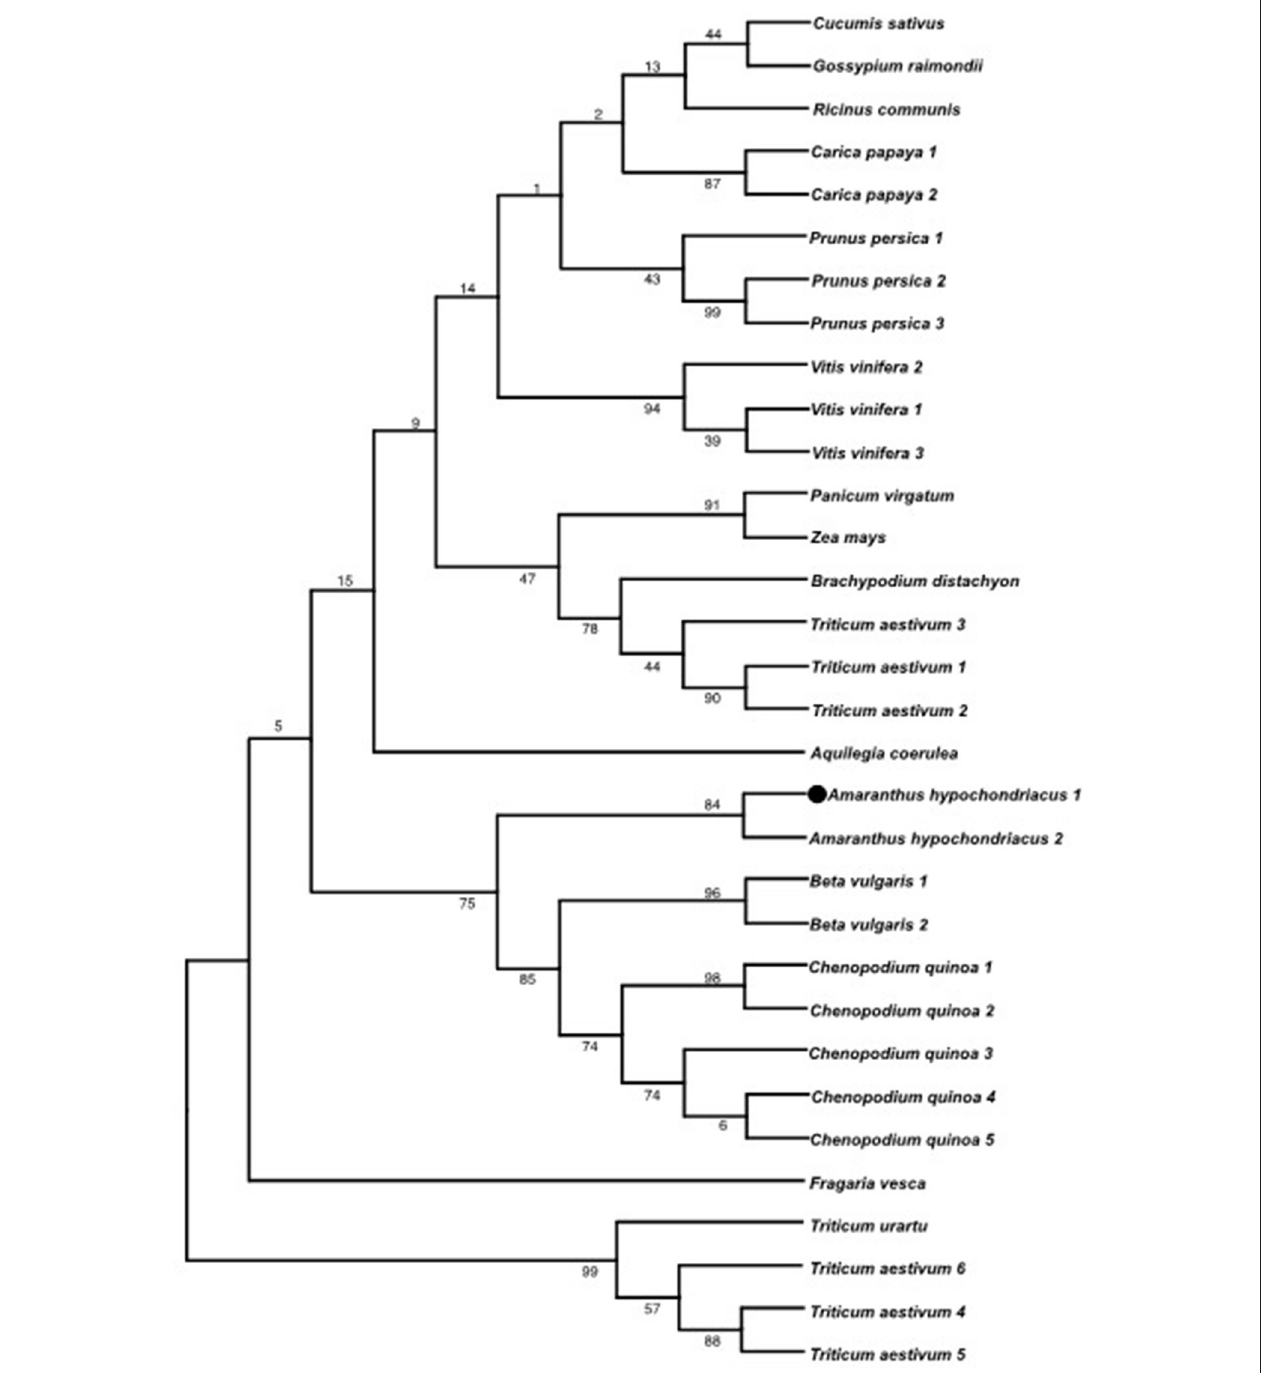
FIGURE 2 | Phylogenetic analysis of the AhN4L-1 protein. The phylogeny shown, obtained by the maximum likelihood method, shows the relationship of AhN4L-1 (represented in the tree as Amaranthus hypochondriacus 1 and marked with a circle) and its homolog, AhN4L-2 ( Amaranthus hypochondriacus 2) , with related proteins reported in closely related plant species (i.e., Beta vulgaris and Chenopodium quinoa ) and with other monocot and dicot plants. The tree was built using MEGA software (version 11.0) using the maximum like-hood method based on the JTT matrix-based model (Jones et al., 1992). The bootstrap value next to the branches was estimated using the bootstrap test (1,000